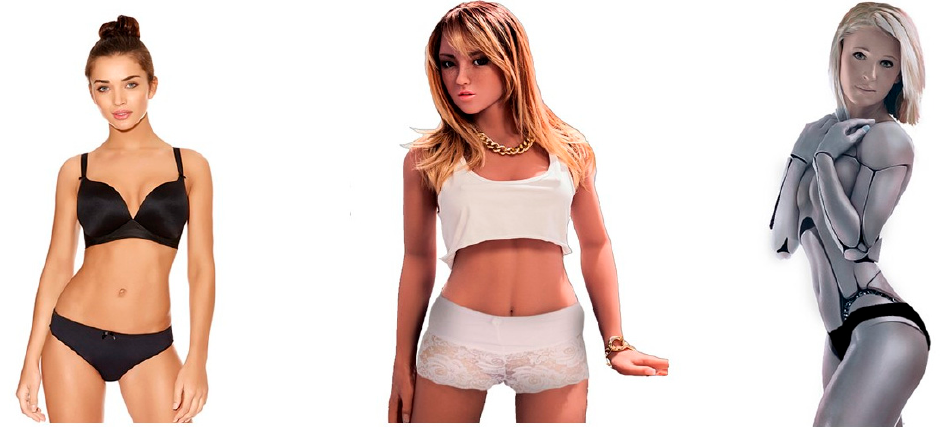
Figure 1. Examples of the stimulus material of the women ( left ); the robots without salient mechanical body parts ( middle ); and the robots with salient mechanical body parts ( right ). Please note that these three categories were used in Study 1a. In Study 1b (affective priming), only pictures of women ( left ) and the robots with salient mechanical body parts ( right ) were shown.